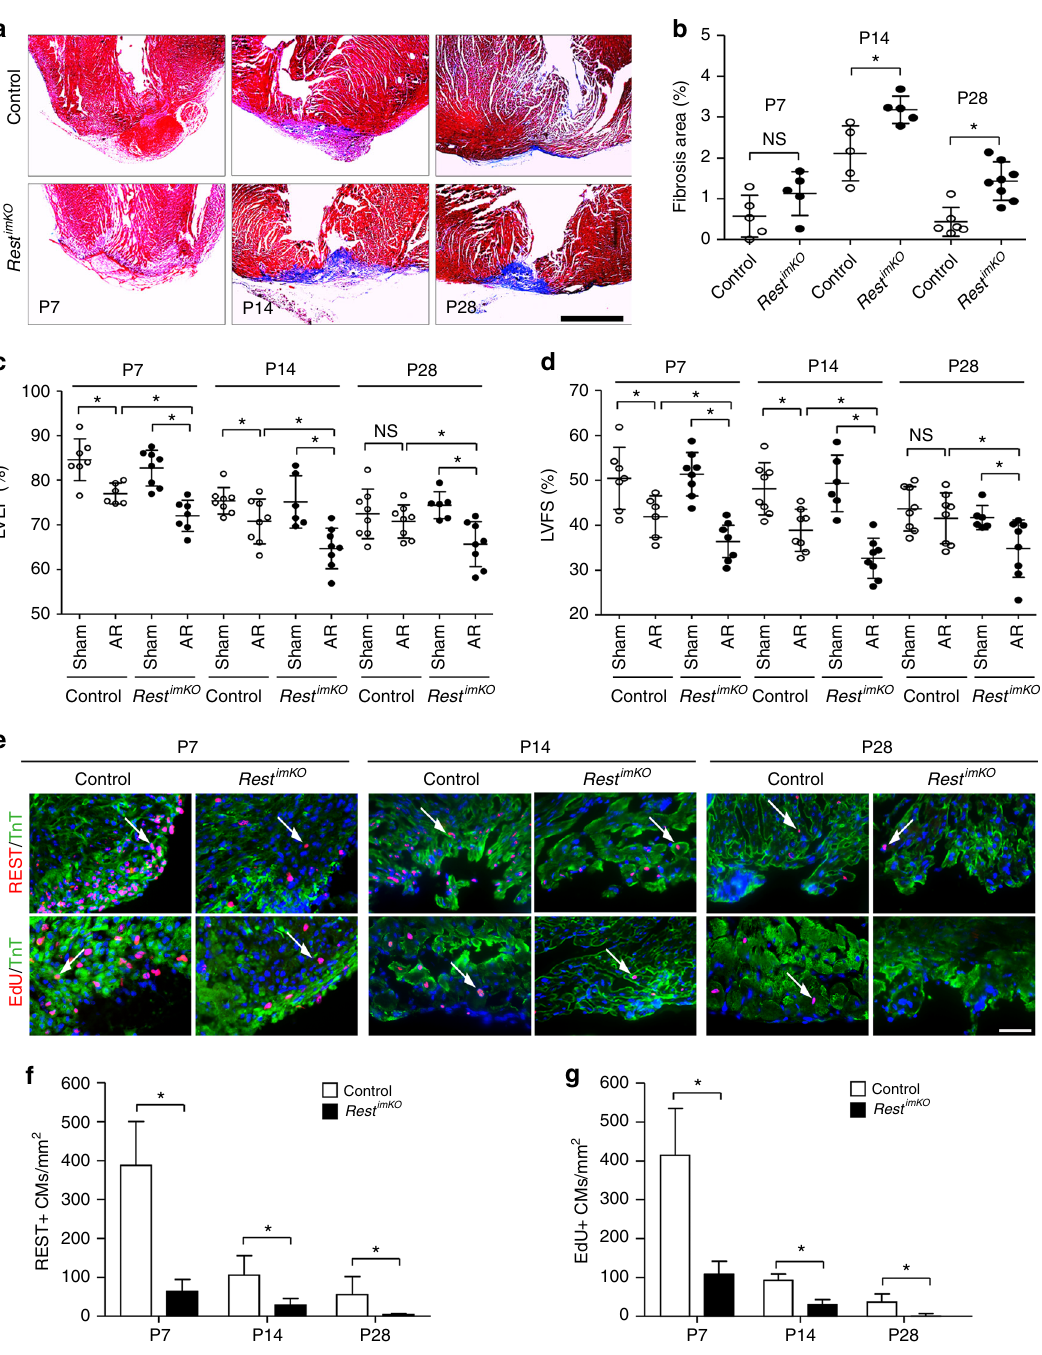
Fig. 7 Rest is required for regeneration of injured neonatal hearts. a , b Quantitative Masson ’ s trichrome staining shows increased cardiac fi brosis in mice with induced myocardial Rest deletion at P3 and injured by apex ablation at P4, n = 5 – 8/group. Scale bar = 100 μ m. c , d Echocardiography indicating reduced cardiac function of myocardial Rest null mice after injury, n = 6 – 8/group. e – g Quantitative immuno fl uorescence ( n = 4/group) showing decreased EdU+ cardiomyocytes in regenerating hearts in mice with Rest deletion. Scale bar = 40 μ m. Mean ± s.d. p < 0.05 by two-way ANOVA followed by Sidak ’ s test in b – d ; unpaired two-tailed Student ’ s t test in f , regulation of cardiomyocyte cell cycle for fetal and neonatal cardiac development.